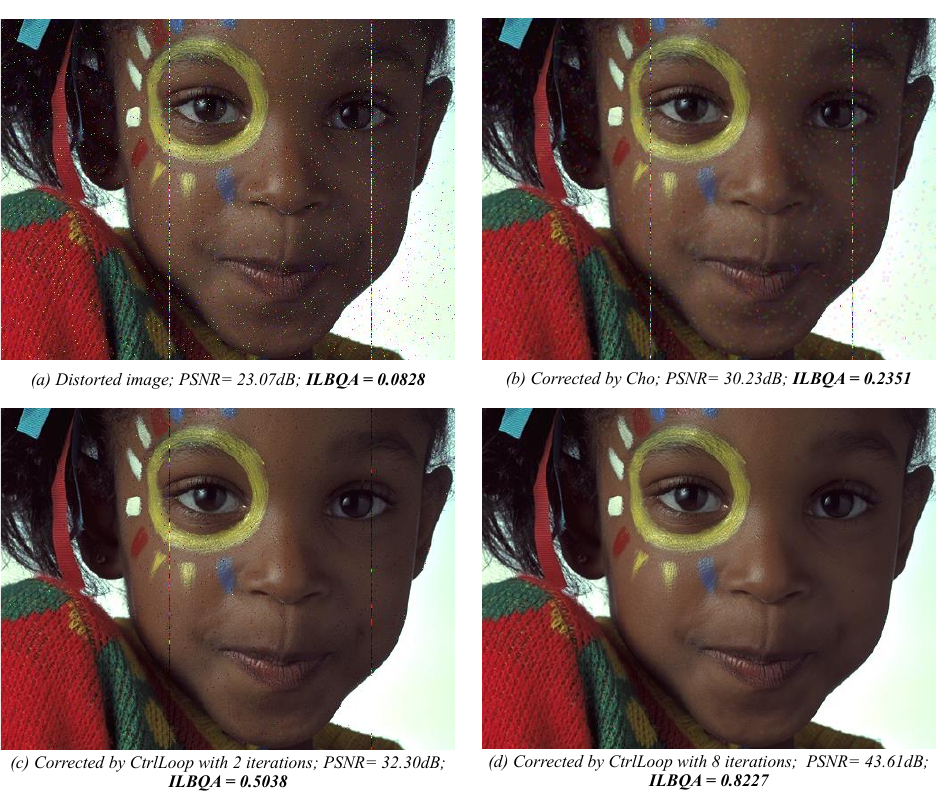
Figure 10. Example of using ILBQA index in a control loop